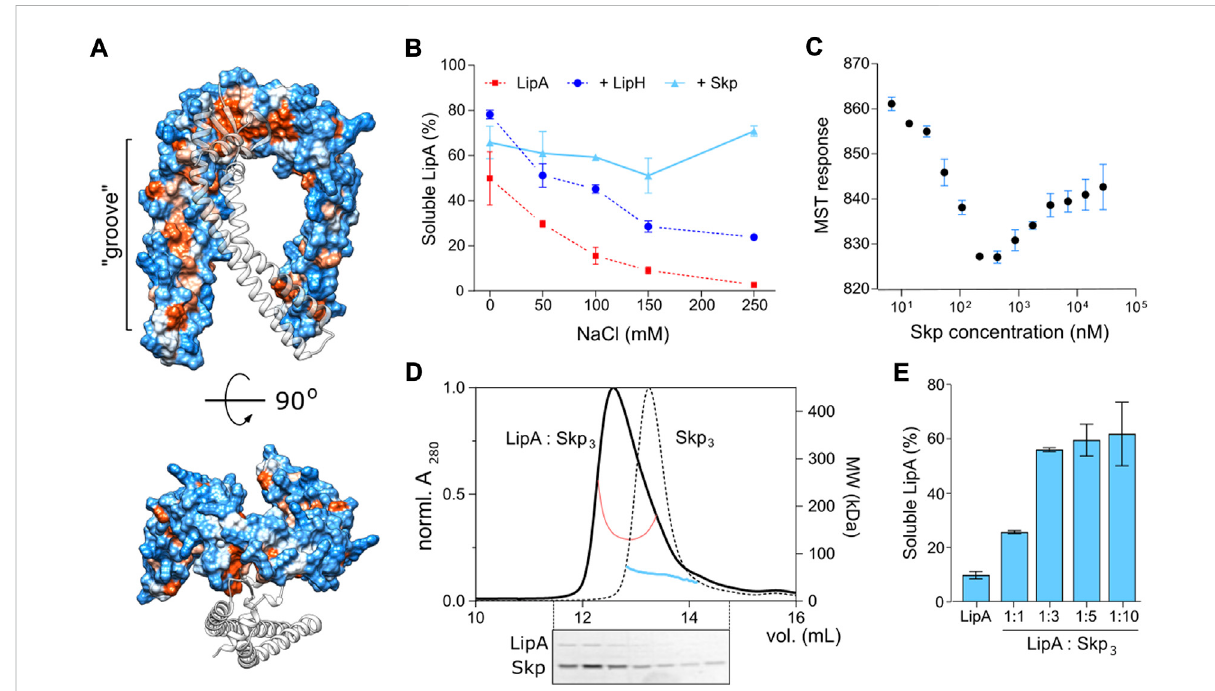
FIGURE 8 Characterisation of LipA:Skp 3 interactions. (A) Surface hydrophobicity plot of P. aeruginosa Skp 3 . The hydrophobic groove along the “ arm ” domain is indicated. Polar/charged residues are shown in blue, apolar in orange. One subunit within the Skp trimer is shown as a transparent ribbon for clarity. (B) Skp supports the solubility of LipA over a broad range of ionic strength. The soluble fraction of the wild-type LipA in presence of Skp (light blue) was determined from SDS-PAGE after the sedimentation assay at various salt concentrations. The assays were performed in technical triplicates, the mean values and SD are shown. Salt-dependent aggregation of LipA alone and LipA in presence of LipH are indicated in red anddarkblue,respectively,andcorrespondtothoseinFigure2B. (C) LipA:Skp 3 interactionsmanifestbiphasicbehaviour.Microscalethermophoresis of LipA F144E :Skp interactions was performed using fl uorescently labelledLipA F144E and Skptitrations (monomers concentration indicated). The high- af fi nityinteractionat20 nM Skpmaybeassigned toLipAbindingasingle chaperone trimer,followed byrecruitment ofthesecond chaperone witha lower af fi nity. The assay was performed in technical triplicates, the mean values and SD are shown. (D) SEC-MALSof the LipA F144E :Skp 3 complex and Skp 3 alone. Normalized UV absorbance of LipA F144E :Skp 3 (solid black line) and Skp 3 (dotted black line), and the corresponding molecular weights are indicated. Below: SDS-PAGE of the LipA F144E :Skp 3 eluate. (E) Solubility of the lipase is dependent of the LipA:Skp 3 ratio. The soluble fraction of the wild-type LipA was determined from SDS-PAGE after the sedimentation assay at various LipA:Skp 3 ratios. The assays were performed in technical triplicates, the mean values and SD are